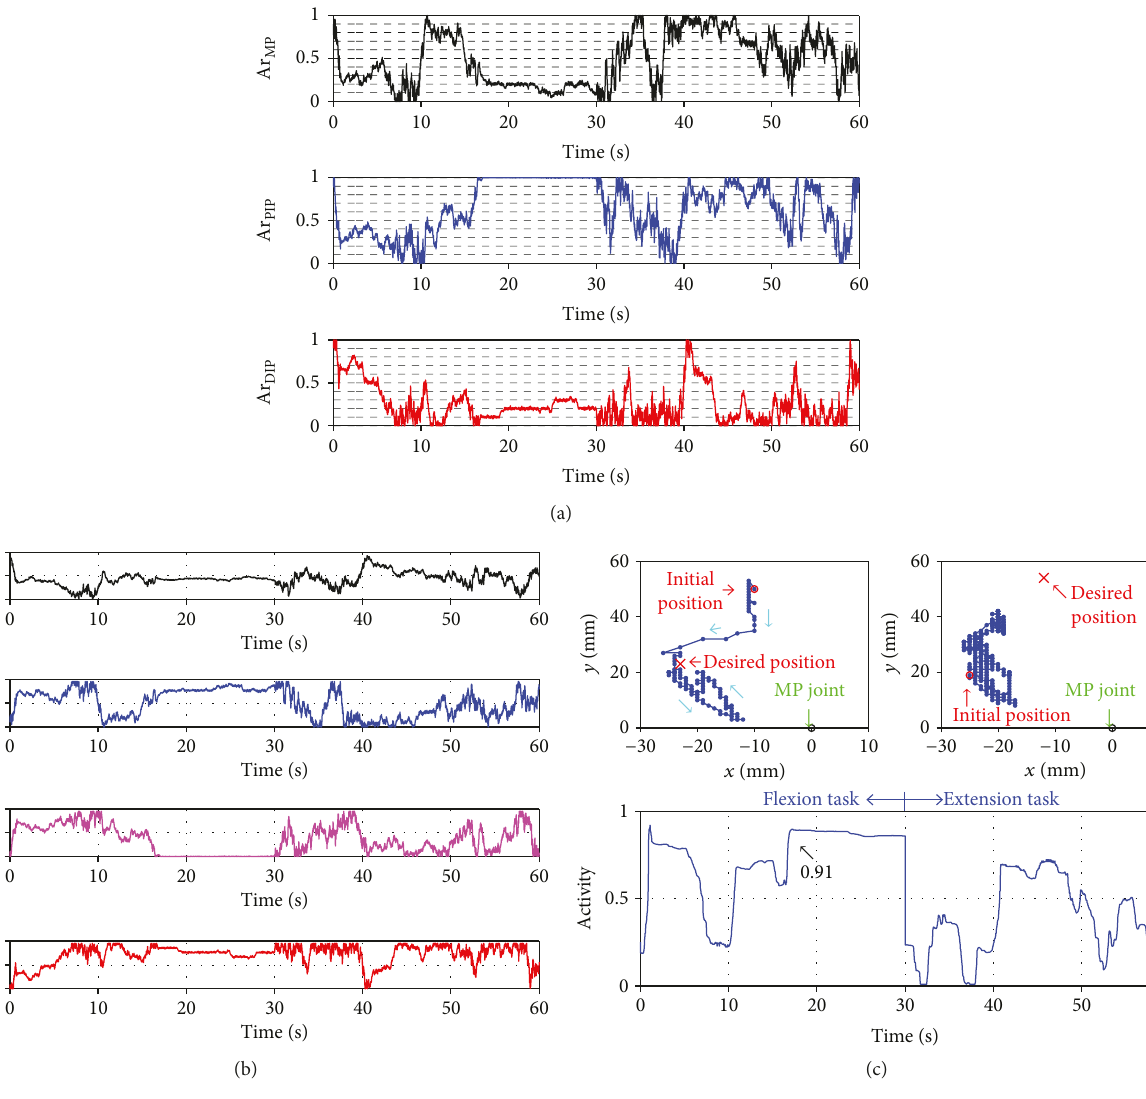
Figure 5: Results using the Ar search-type controller. (a) Plots of the transition of the search variable ( Ar attractors (dashed lines). (b) Plots of the transition of the input pressures ( P e , P MPf , P PIPf , and P DIPf ). (c) Plots of the trajectory of the tip of the robot on the fl exion task (top-left) and the extension task (top-right) and the transition of the Activity (bottom). Cyan arrows, green arrows, and black arrows show the direction of the movement, the MP joint position, and the value of Activity ,